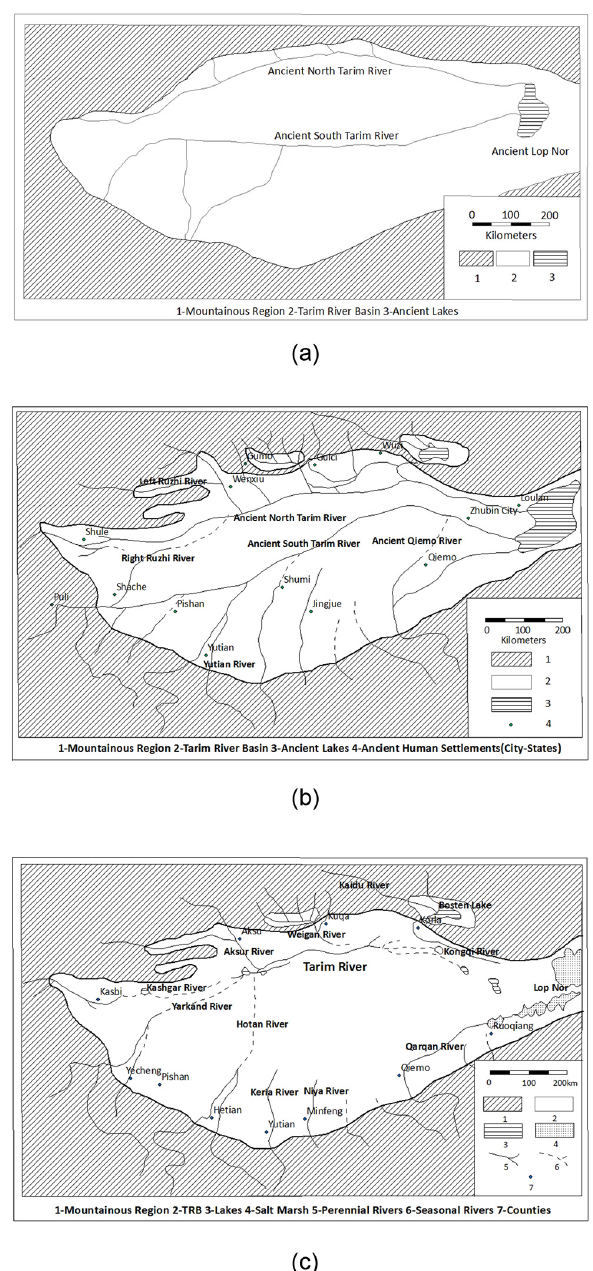
Fig. 4. Evolution of Tarim River system during the past tens of thou- sands of years: (a) TRB in the late Pleistocene (about 10000 years ago); (b) TRB from the 4th to 5th centuries; (c) TRB today (adapted from Fan, 1991; Bai,